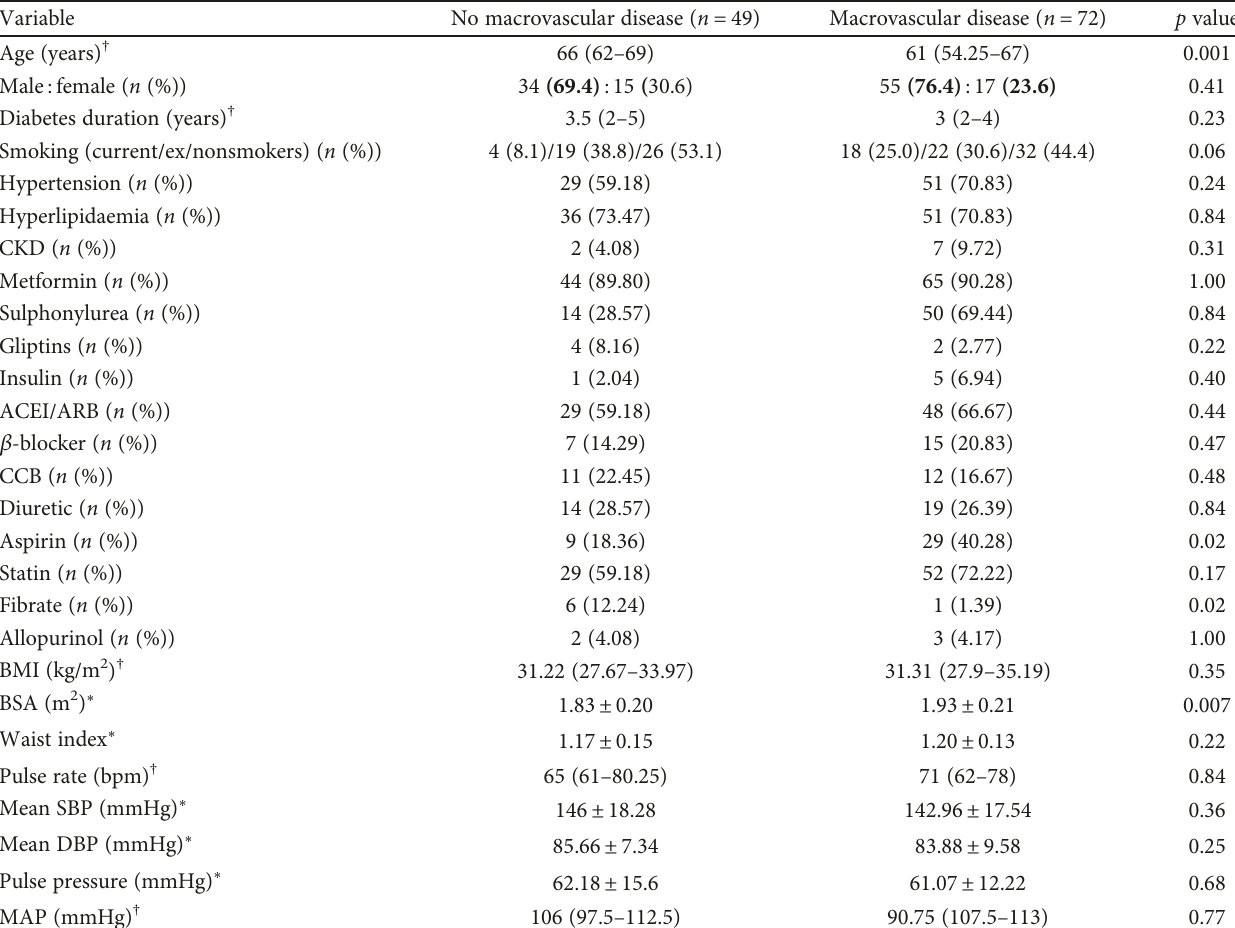
Table 3: Demographic and clinical fi ndings of subjects with and without macrovascular